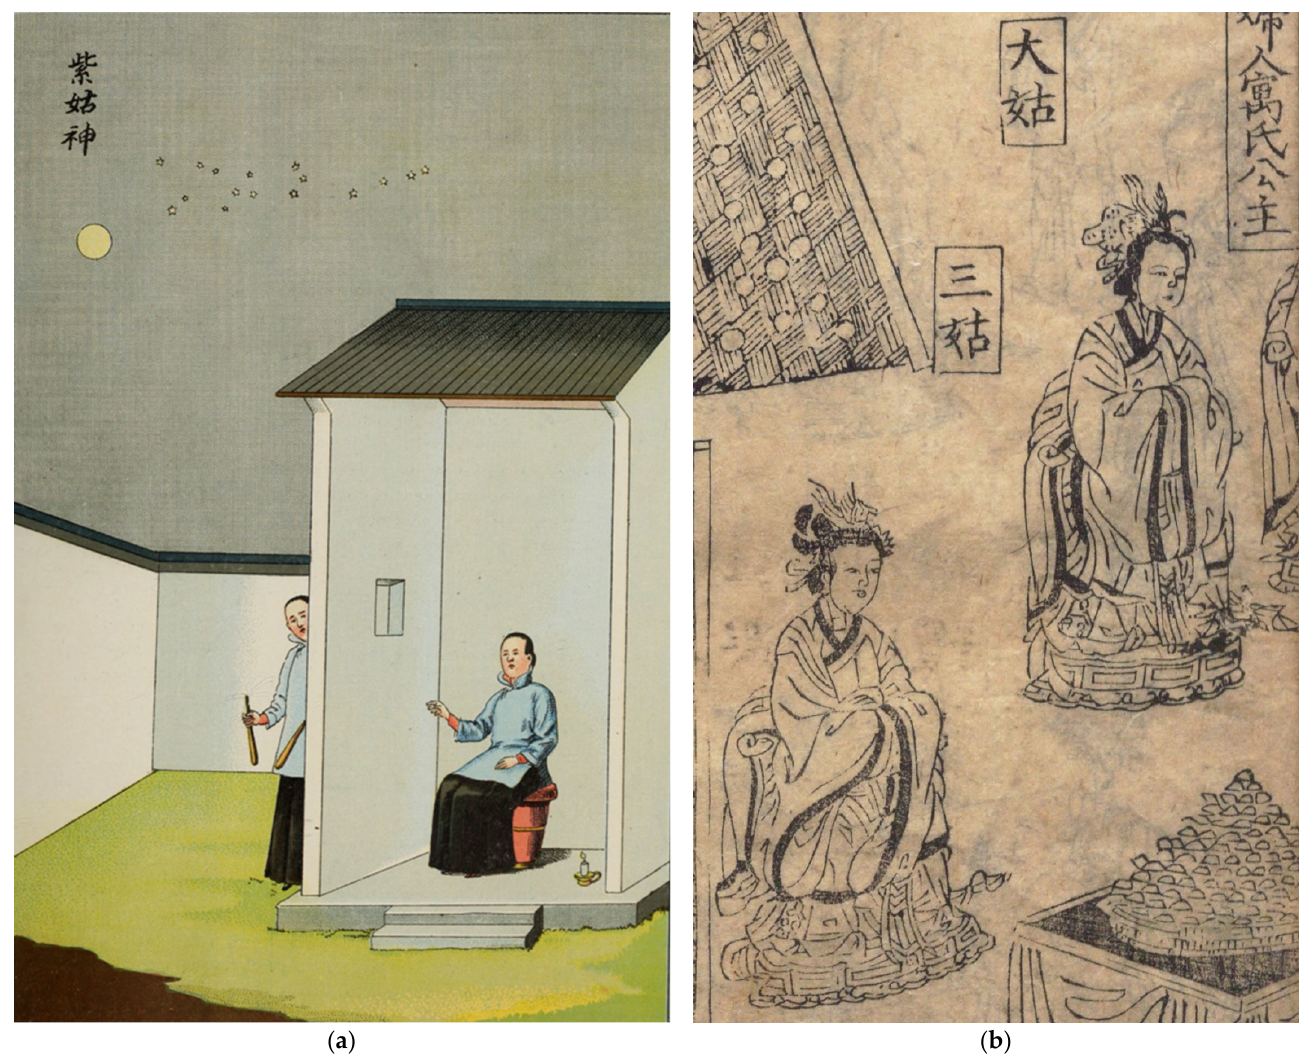
Figure 9. “Zi-Gu Goddess 紫姑神 ”: ( a ) “Zi-Gu Goddess 紫姑神 ” (Henri 1916, p. 126); ( b ) “Da-Gu” and “San-Gu”. Photo source: Nong Shu 农书 (1304).